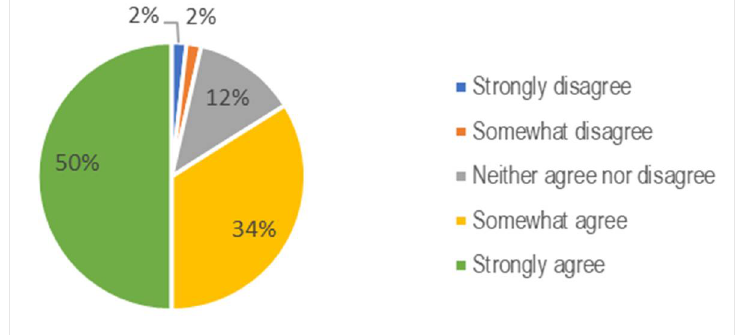
Figure 16. Co-benefits of sequestering carbon and providing habitat using vegetation in the built environment.